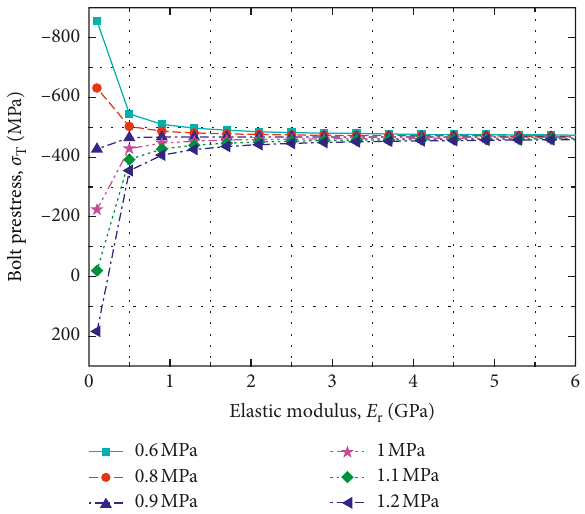
Figure 16: Matching relation between rock stiffness and bolt prestress considering the bearing capacity of rock